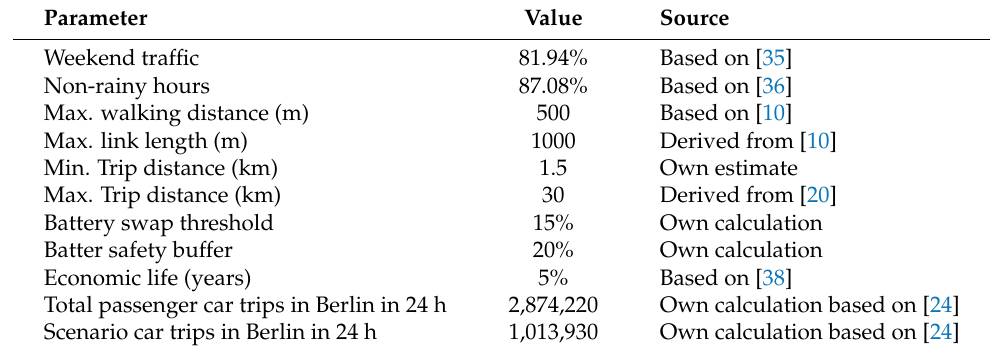
Table 2. Simulation